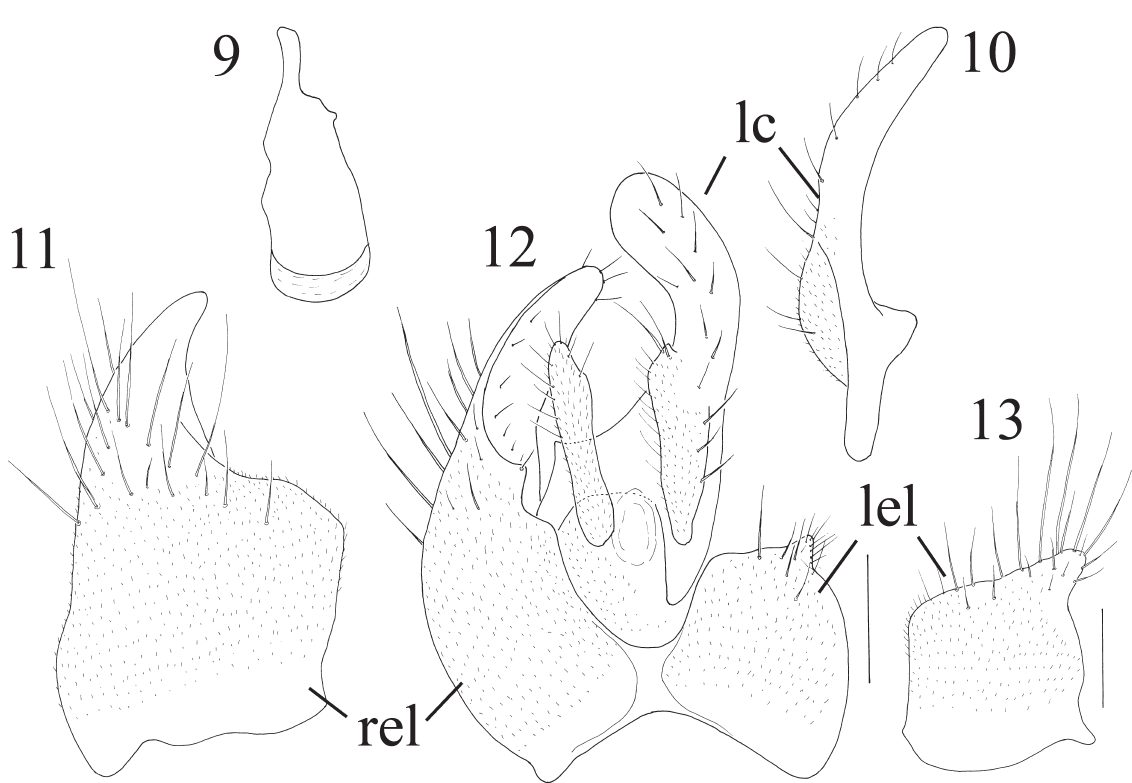
Figs 9–13. Platypalpus ikoso sp. nov., holotype ♂. 9 . Hypandrium. 10 . Left cercus. 11 . Right epandrial lamella. 12 . Epandrium with cerci, dorsal view. 13 . Left epandrial lamella. Scale bars = 0.1